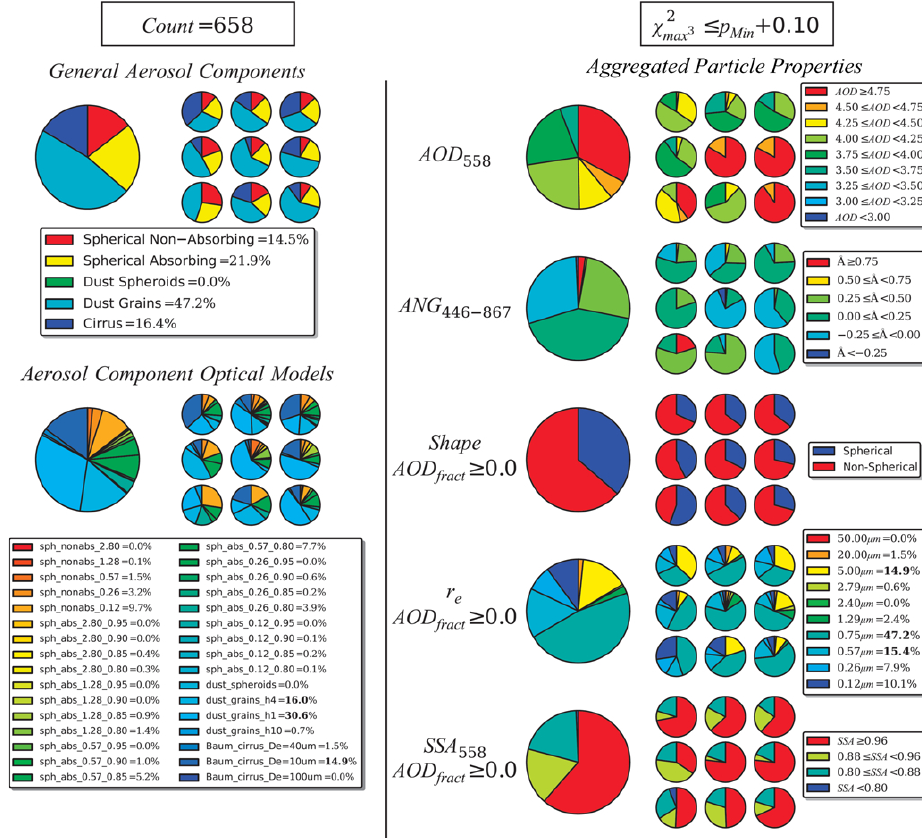
Fig. 4. Summaries of the MISR Research Retrieval results for the nine retrieval regions, each 5 × 5 1.1km pixels in size, located 250km downwind of the volcano over the main plume on 7 May 2010 in Patch P2 of Fig. 3c, for the AOD-weighted averages of all mixtures in the < p min + 0 . 1. (See text, Sect. 2, for a detailed explanation of the features of 1200 mixing groups that meet the acceptance criterion χ 2 max3 this